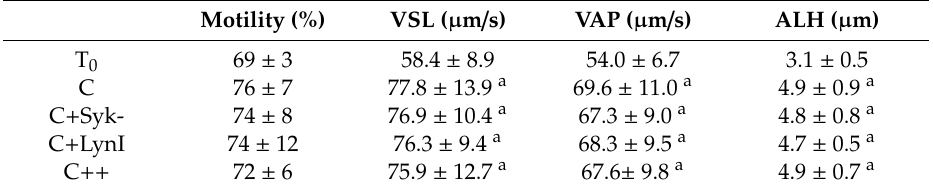
Table 2. Sperm motility and kinematic parameters observed in di ff erent samples, evaluated with computer-assisted sperm analysis (CASA) at T 0 (before starting incubation) and after 120 min of incubation in capacitating conditions in absence (C) or presence of SykI, LynI, or both. Motility = progressive and non-progressive motility (%); VSL = straight-line velocity ( µ m / s); VAP = average path velocity ( µ m / s); ALH = amplitude of lateral head displacement ( µ m). Motility (%) VSL ( µ m / s) VAP ( µ m / s) ALH ( µ m) T 0 69 ± 3 58.4 ± 8.9 54.0 ±